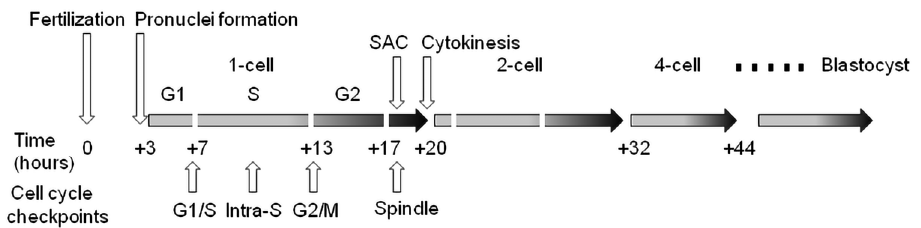
Figure 1. Cell cycle checkpoints in the temporal context of cleavage of the early mouse embryo. Time values are averages due to variability between individual lines of laboratory mice. SAC—spindle assembly checkpoint.